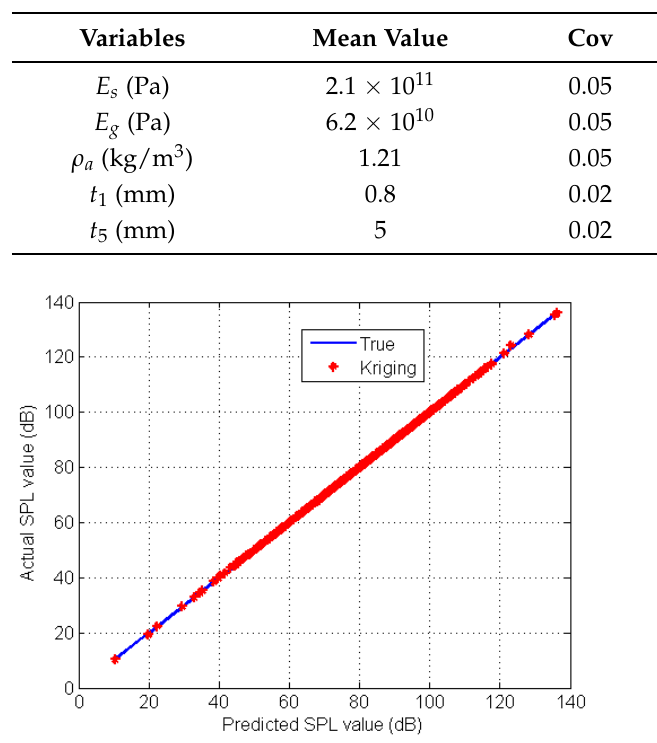
Table 5. Characteristics of uncertain parameters.